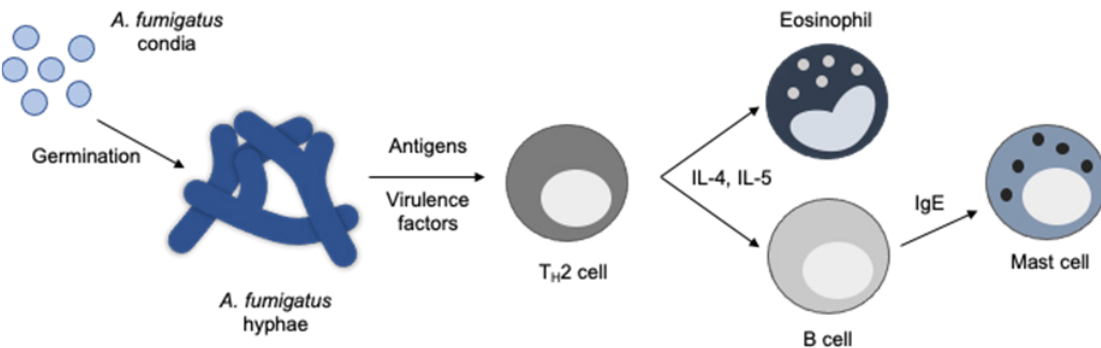
Figure 1. Pathophysiology of ABPA. Inhalation of fungal conidia and subsequent germination of fungal hyphae results in the expression of antigens specific to hyphal growth. These antigens are recognized by the immune system and cause a T H 2 driven immune response marked by increased levels of T H 2 cytokines, recruitment of eosinophils to the lung and increased production of IgE. The activation of eosinophils and mast cells drive the pathophysiology of ABPA and the resulting clinical symptoms.